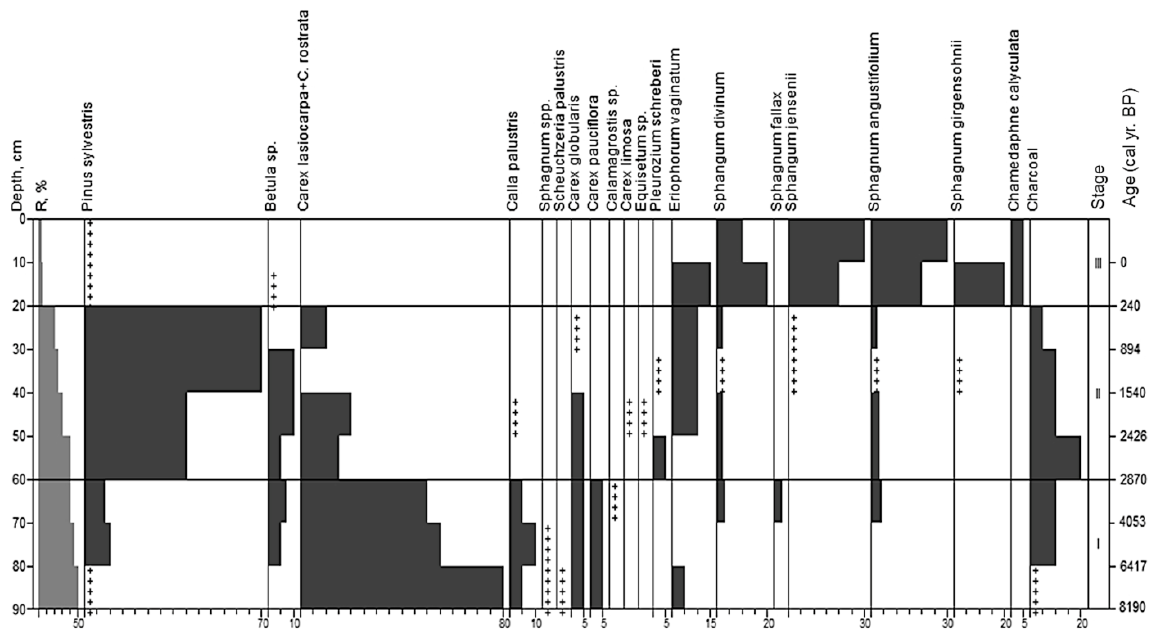
Figure 3. Macrofossil diagram for site 0. Stages correspond to paleo-communities: ( I )— Carex lasiocarpa + C. rostrata ; ( II )— Pinus sylvestris+Betula sp.-herbs; ( III )— Ericales - Eriophorum vaginatum-Sphagnum divinum + S. angustifolium ; +—abundance less than 5%.